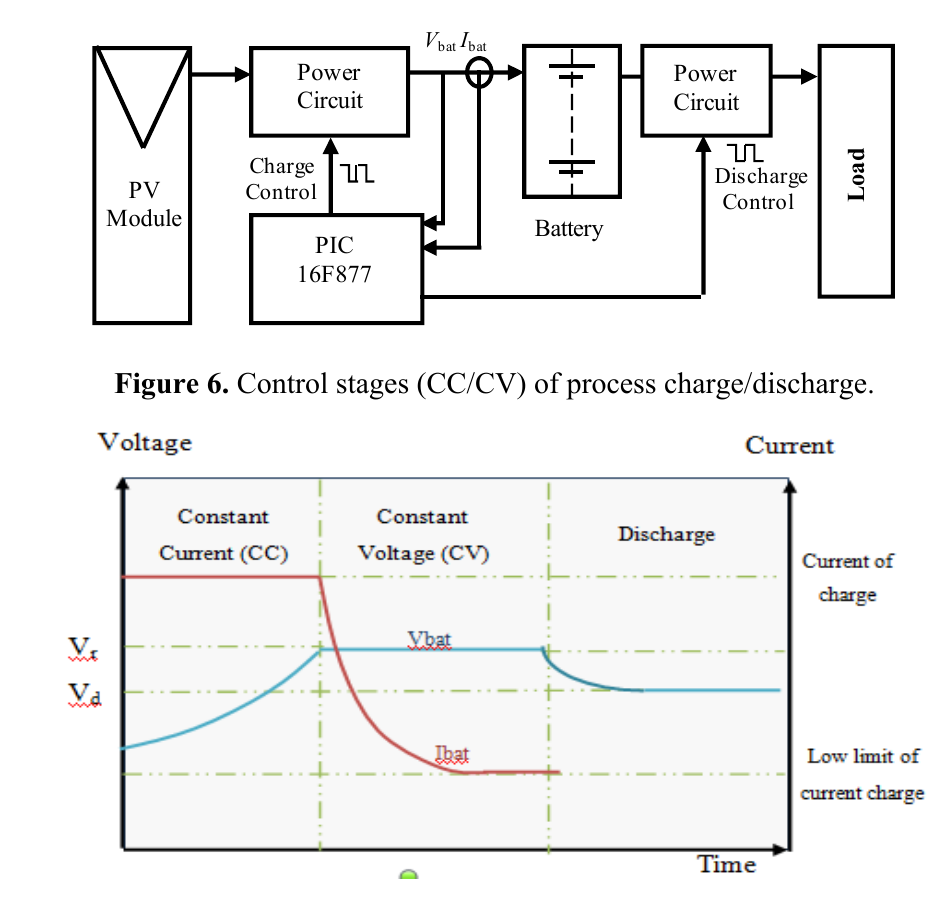
Figure 5. Synoptic diagram of control system.